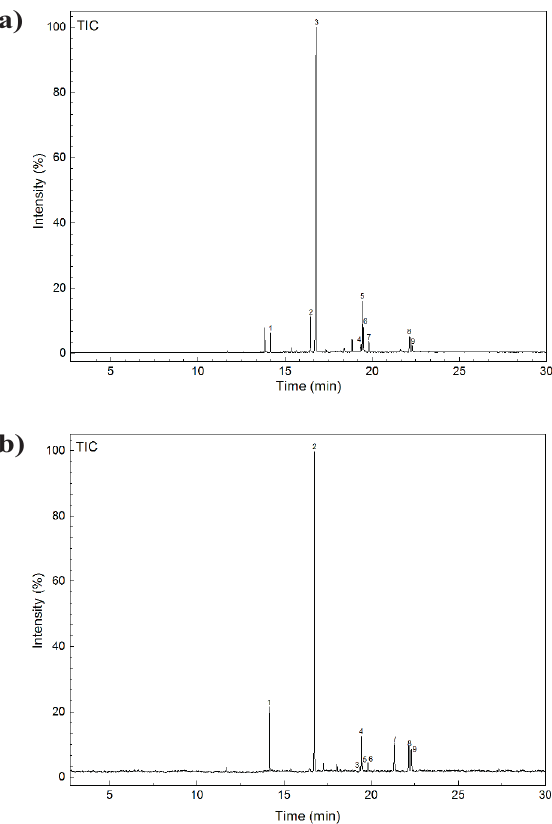
Figure 1 - Chromatograms of fatty acids from marine red algae Pterocladiellacapillacea ( a ) and Osmundariaobtusiloba ( b ) obtained by gas chromatography mass spectrometry